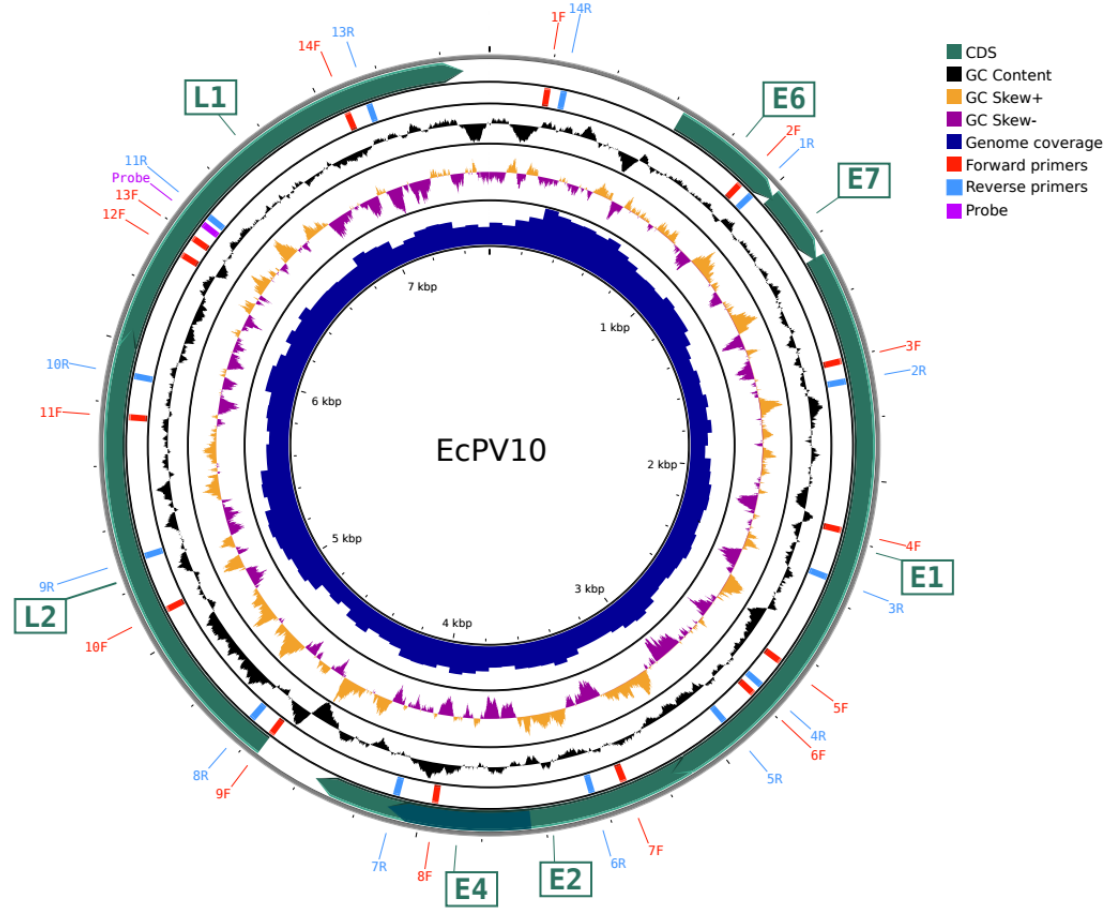
Figure 1. Genomic multi-plot showing the newly assembled EcPV10 genome. The genomic multi-plot was obtained with CGview REF. Concentric circles, from outermost to innermost, show the following: the backbone of the EcPV10 genome; CDS in green arrows; overlapping primers for the genome walking validation method, in forward (red) and reverse orientation (blue); GC content percentage; GC skew, in orange for the forward strand and purple for the reverse strand; Illumina short reads coverage on the assembled sequence.